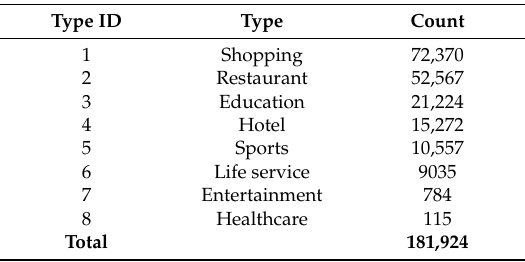
Table 2. Beijing points of interest (POI)